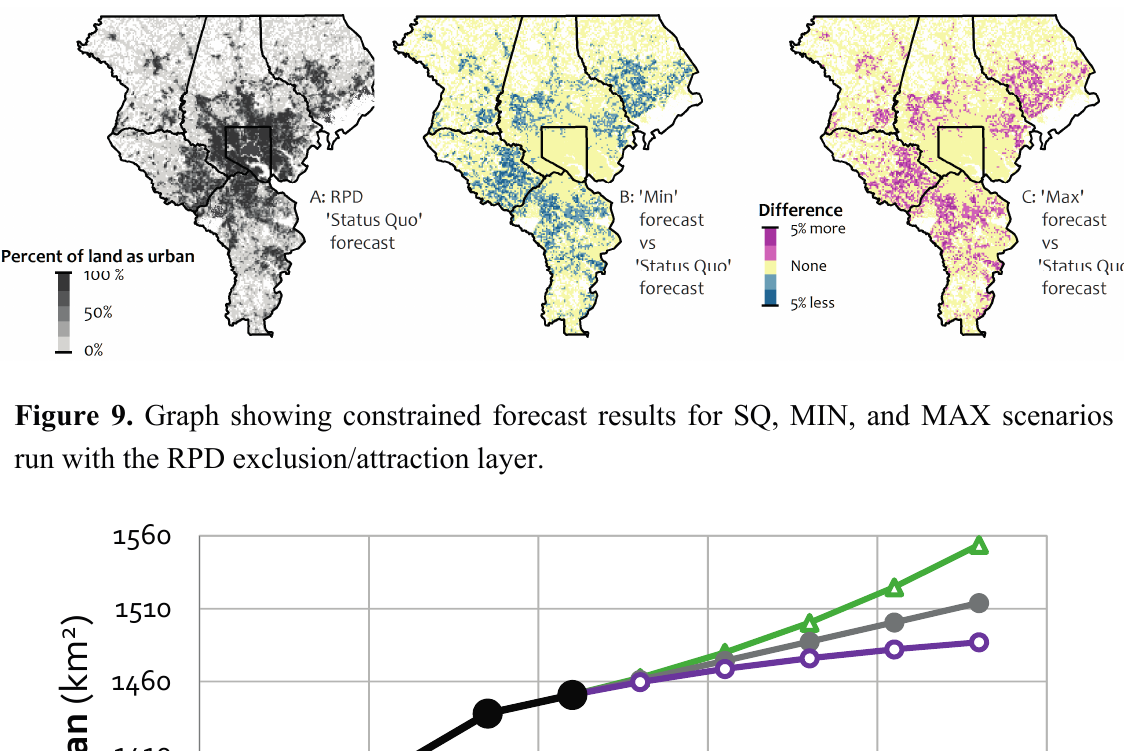
Figure 8. Maps showing constrained forecast results for ( A ) SQ, ( B ) MIN and ( C ) MAX and for RPD exclusion/attraction layer.